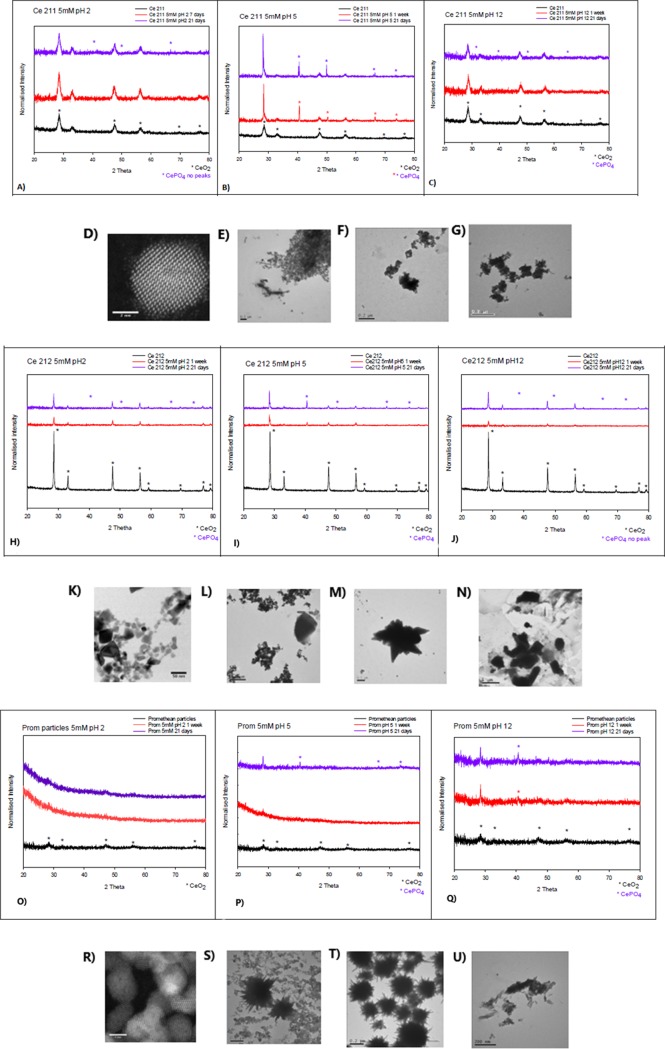
XRD and TEM results obtained for 5mM phosphate.XRD results obtained for Ce NM-211 (A-C), Ce NM-212 (H-J) and PROM-Ce (O-Q) after 1 week and 21 days at different pH in 5mM phosphate solution. TEM results after 21 days for Ce NM-211 (D-G), Ce NM-212 (K-N) and PROM-Ce (R-U), corresponding to pristine particles (D, K, R), pH 2 (E, L, S), pH 5 (F, M, T) and pH 12 (G, N, U).